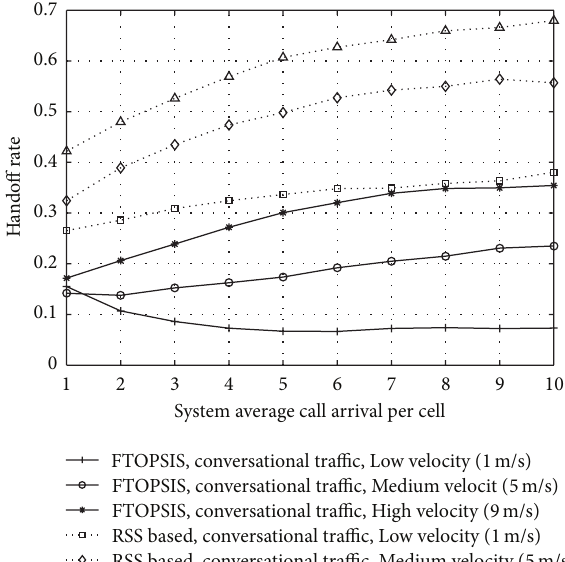
Figure 10: Handoff rate using